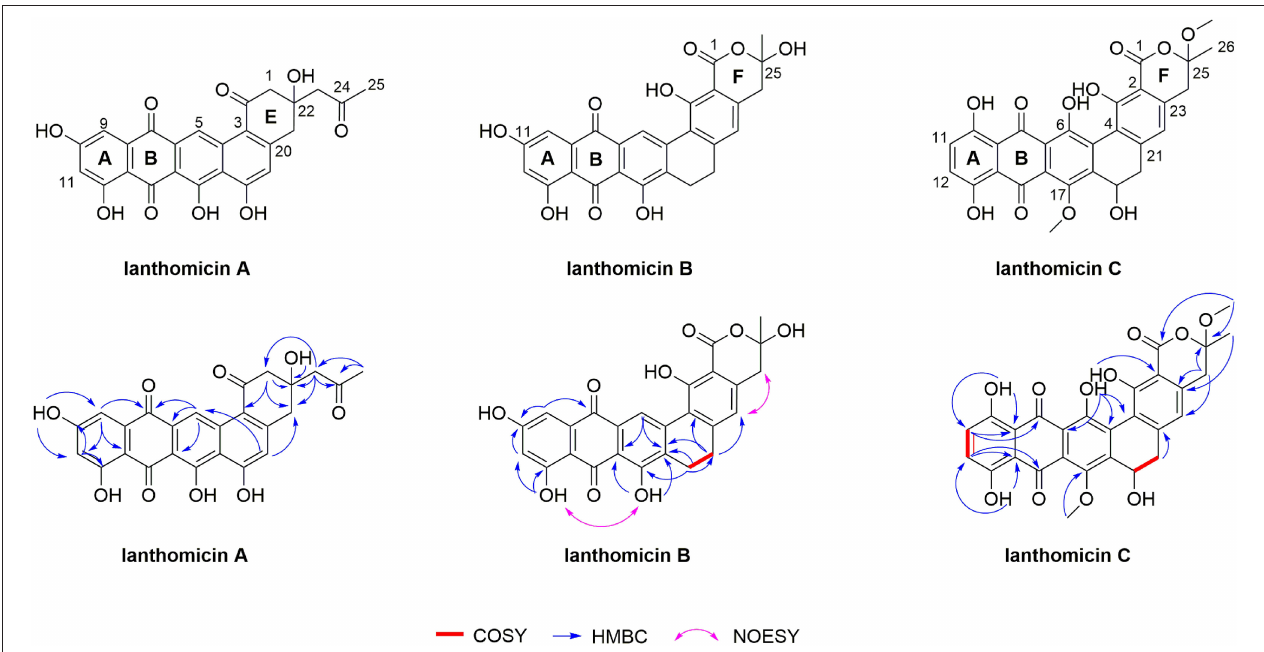
FIGURE 5 | Planar structures of lanthomicin A-C. Key COSY, HMBC, and NOESY correlations of lanthomicin A–C are indicated.